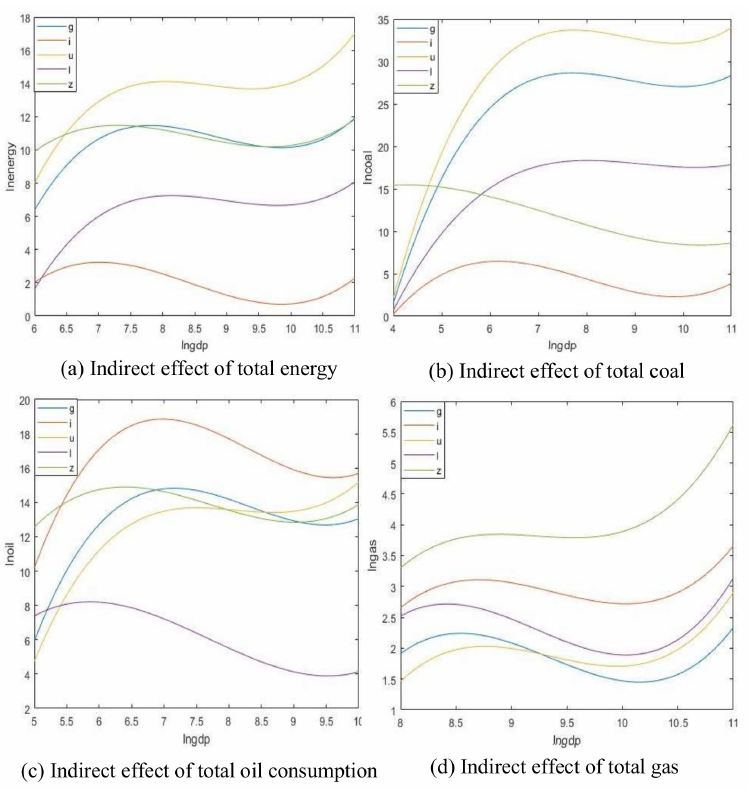
Figure 4. Spatial spillover e ff ect fitting diagram of indirect e ff